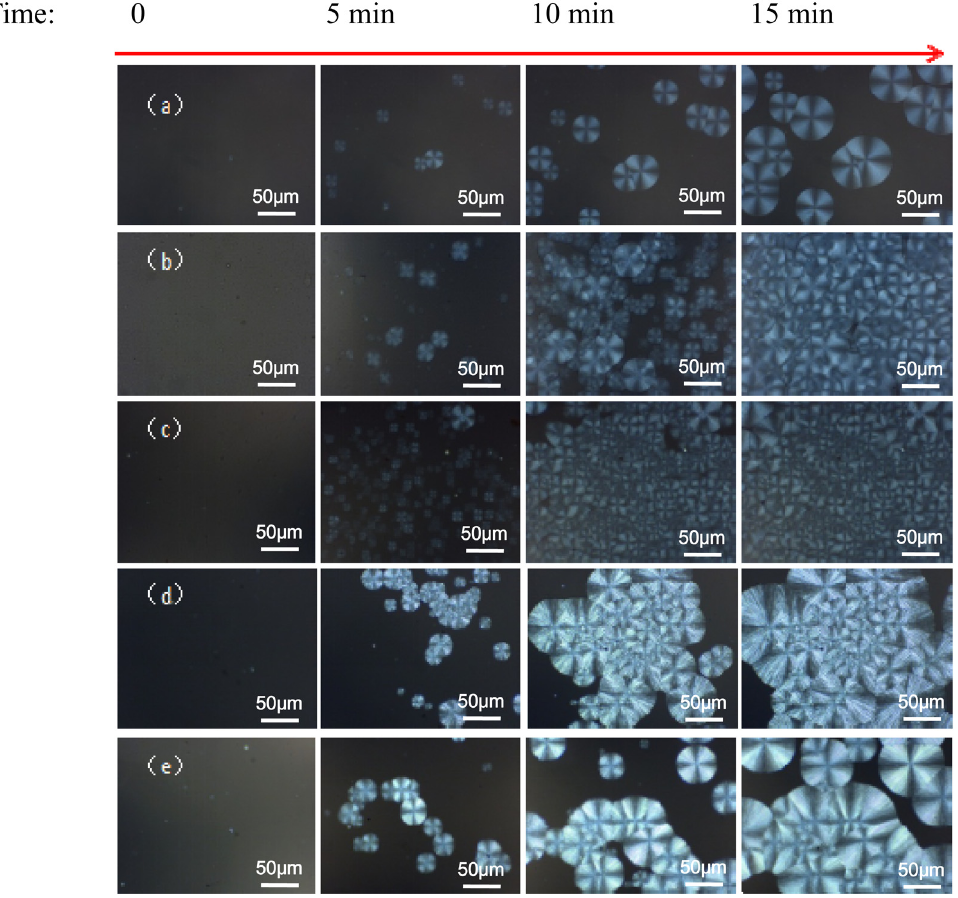
Figure 4: The POM images (× 200 ) of spherulite growth during isothermal crystallization at 60°C after di ff erent time at 0, 5, 10, and 15 min for: ( a ) PHBH, ( b ) 1 wt% MMT/PHBH, ( c ) 3 wt% MMT/PHBH, ( d ) 5 wt% MMT/PHBH, and ( e ) 7 wt%